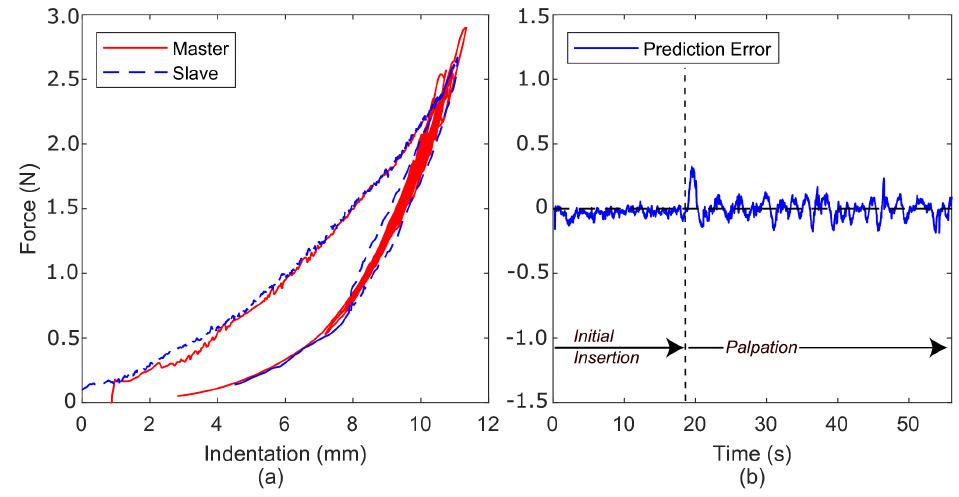
Figure 13. ( a ) Force-indentation profile using the Hunt–Crossley force model as the virtual environ- ment. Note that only the slave force outer envelope is presented for clarity. ( b ) The force-feedback prediction